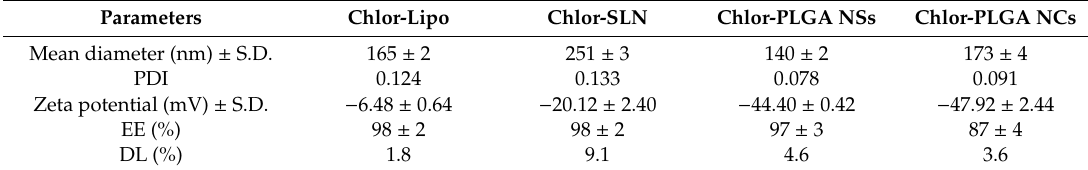
Table 1. Physico-chemical characteristics of Chlor-loaded nanocarriers ( n = 3). Parameters Chlor-Lipo Chlor-SLN Chlor-PLGA NSs Chlor-PLGA NCs Mean diameter (nm) ± S.D. 165 ± 2 251 ± 3 140 ± 2 173 ± 4 PDI 0.124 0.133 0.078 0.091 Zeta potential (mV) ± S.D. − 6.48 ± 0.64 − 20.12 ± 2.40 − 44.40 ± 0.42 − 47.92 ± 2.44 EE (%) 98 ± 2 98 ± 2 97 ± 3 87 ± 4 DL (%) 1.8 9.1 4.6 3.6 Different liposomal formulations were tested and liposomes composed of